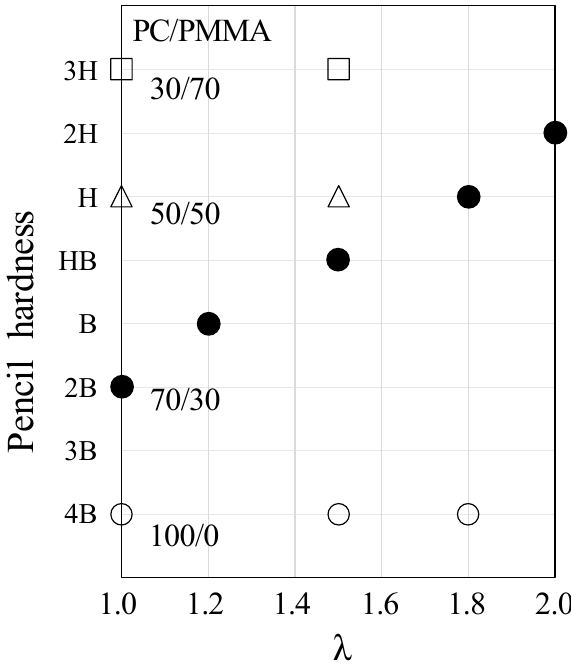
Figure 11. Surface hardness of PC/PMMA blends obtained by simultaneous biaxial stretching at various draw ratios λ . ◯ : 100/0 PC/PMMA; ● : 70/30 PC/PMMA; △ : 50/50 PC/PMMA; □ : 30/70 PC/PMMA.